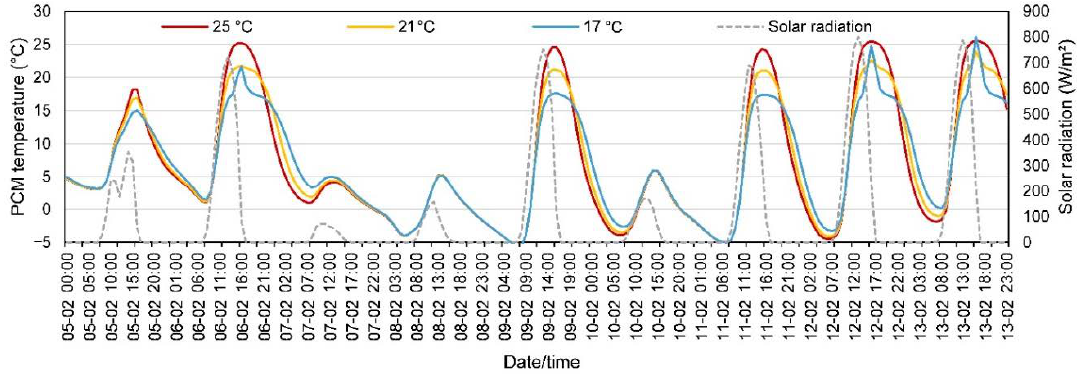
Figure9. ThePCMtemperatureprofilesformodelsusingPCMwithdi ff erentphasechangetemperatures Figure 9. The PCM temperature profiles for models using PCM with different phase change for winter energy storage temperatures for winter energy storage application.